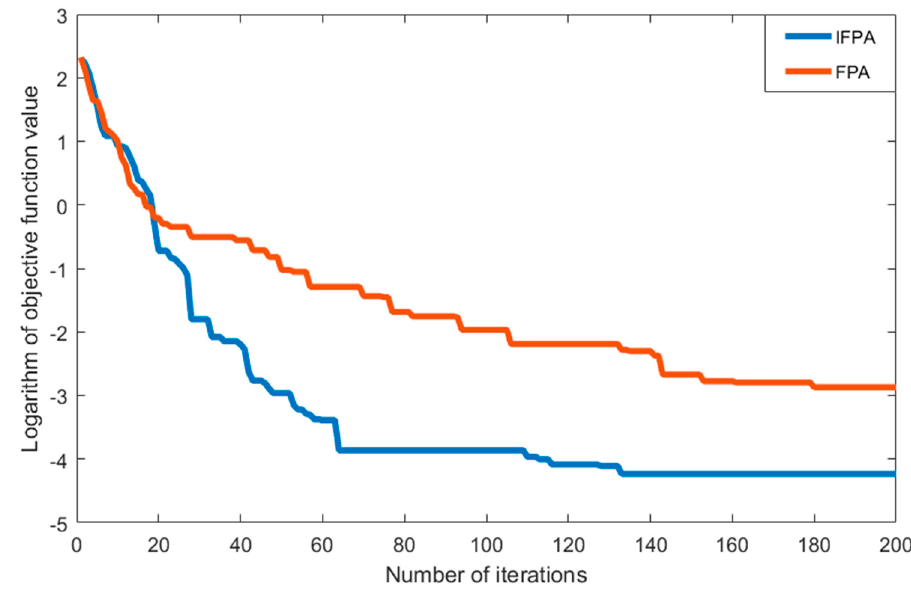
Figure 6. Iterative convergence curve from the Ackley function.